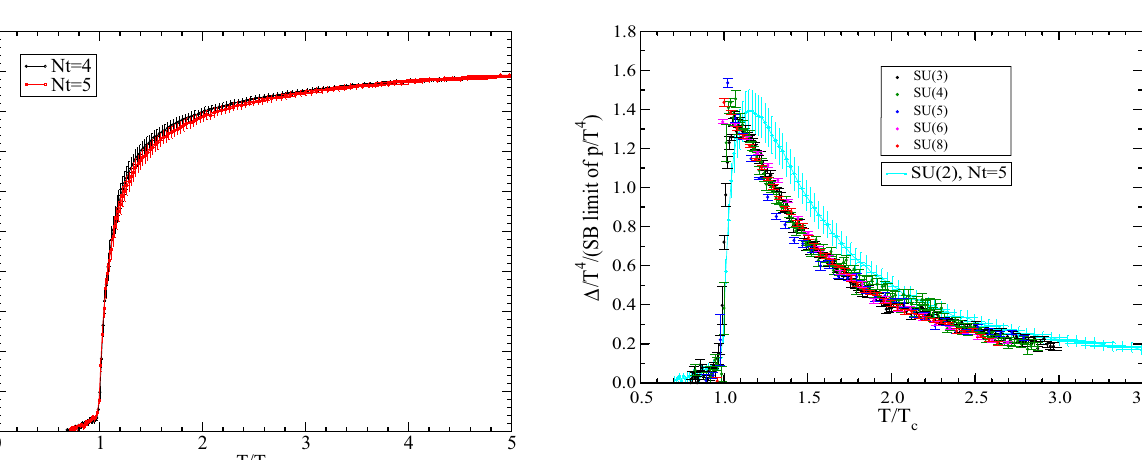
Fig. 18 Comparison of the trace anomaly in the deconfined phase, measured in this work, i.e. SU(2), with the determinations in SU( N c ) of Ref. [16]